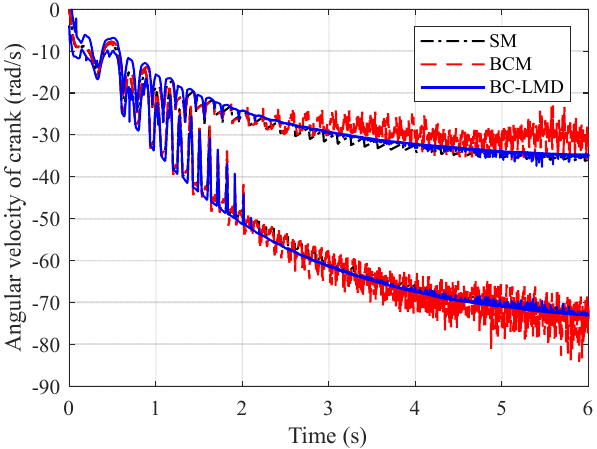
Figure 4. Bounds of the angular velocity of the crank.